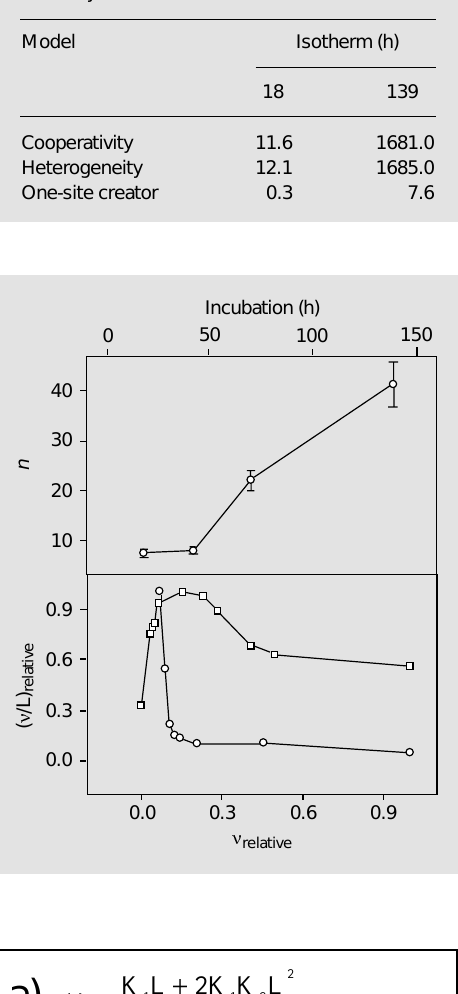
Figure 2. Equations provided for nonlinear adjustments of coop- erativity (a; 23), heterogeneity (b; 19), and one-site creator (c; 24). Models were applied to the equilibrium data at 18 and 139 h. K i is the binding constant for the interaction, L is the free ligand concentration, and n i is the i site population for the